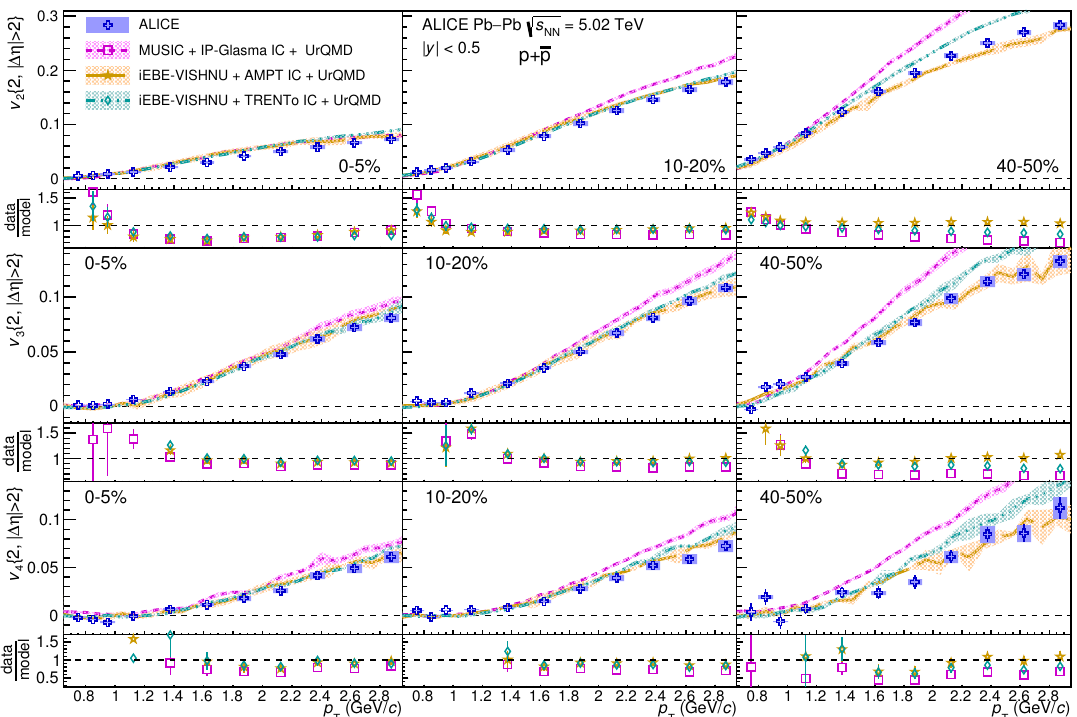
Figure 14 . (Colour online) The p T -di(cid:11)erential v 2 (top), v 3 (middle), and v 4 (bottom) of p+p for the 0{5%, 10{20%, and 40{50% centrality classes compared to hydrodynamical calculations from MUSIC model using IP-Glasma initial conditions (magenta) [82] and the iEBE-VISHNU hybrid model using AMPT (orange) or TRENTo (cyan) initial conditions [83]. Statistical and systematic uncertainties of the data points are shown as bars and boxes, respectively. The uncertainties of the hydrodynamical calculations are depicted by the thickness of the curves. The ratios of the measured v n to a (cid:12)t to the hydrodynamical calculations are also presented for